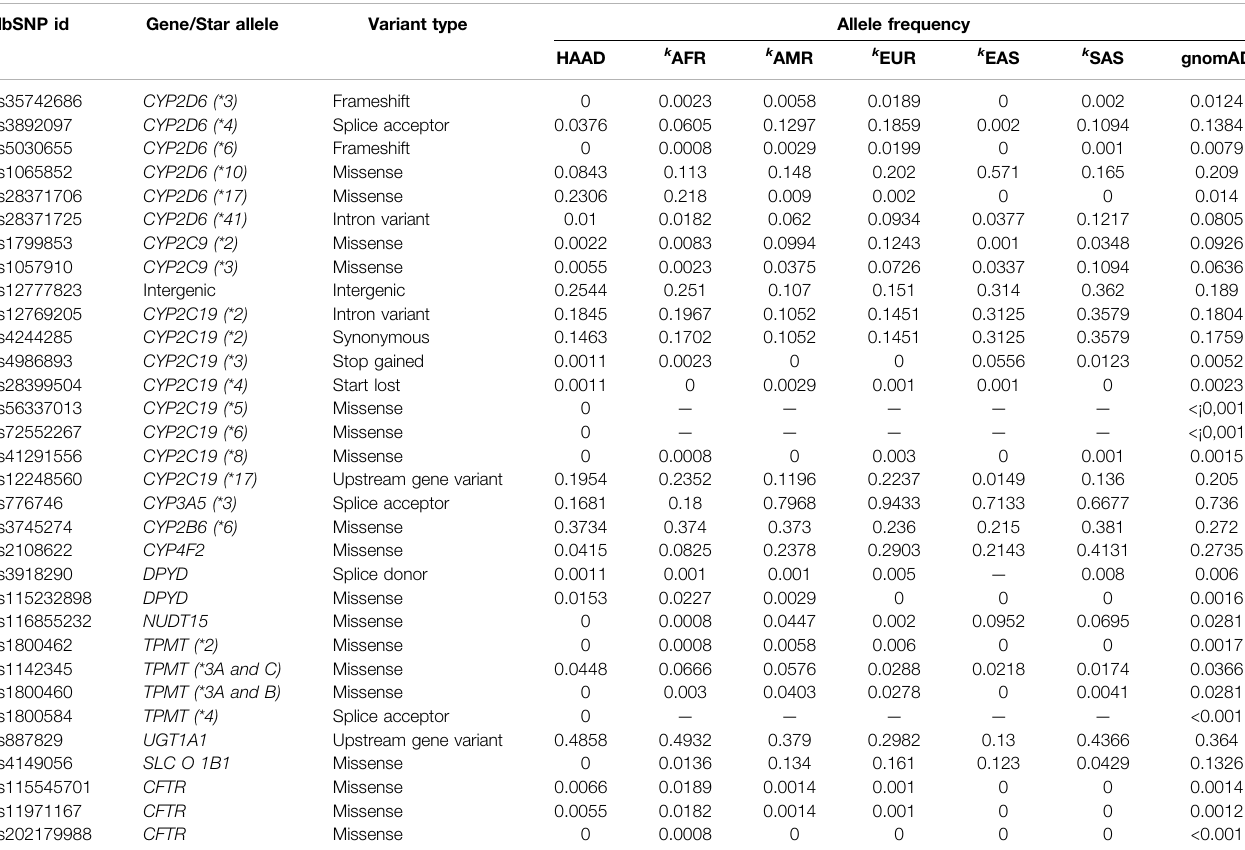
TABLE 4 | Allele frequency of the clinically actionable variants (PharmGKB 1A/B) in the combined HAAD dataset compared to the KGP super populations k as well as gnomAD.